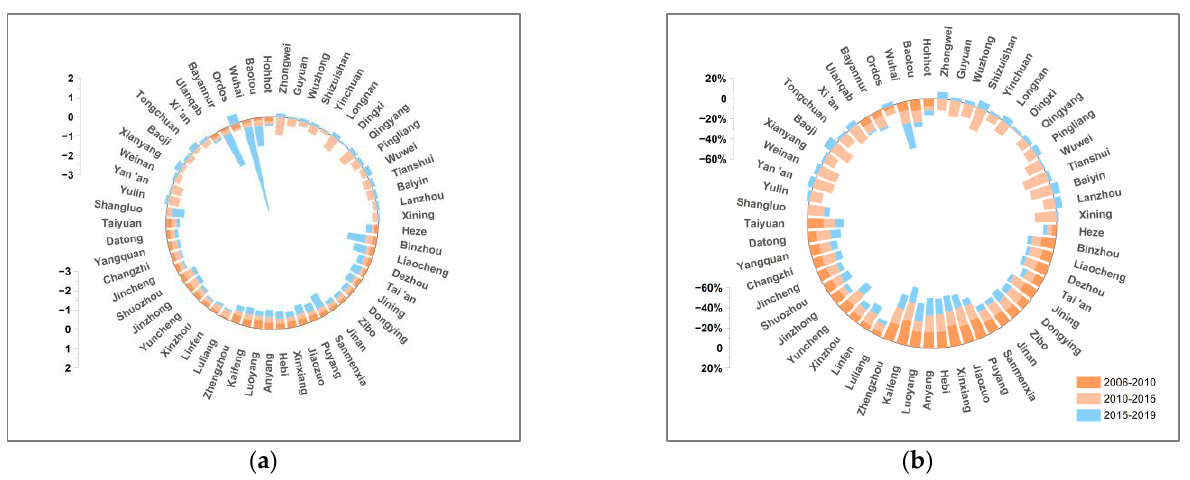
Figure 11. Contribution and contribution rate of carbon-emission-coefficient factor. ( a ) Contribution of carbon-emission-coefficient factor. ( b ) Contribution rate of carbon-emission-coefficient factor.